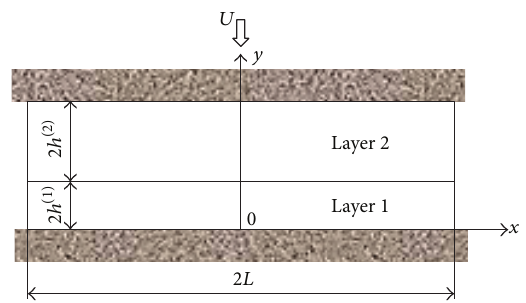
Figure 1: Compression of a two-layer strip between rough rigid